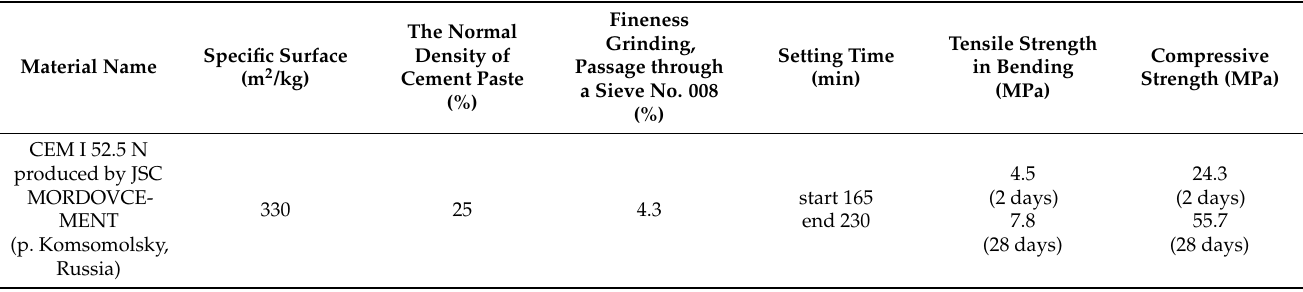
Table 1. Characteristics of the binder.